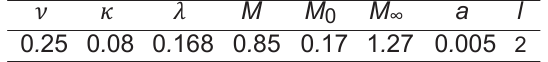
Table 1: Reference material parameters